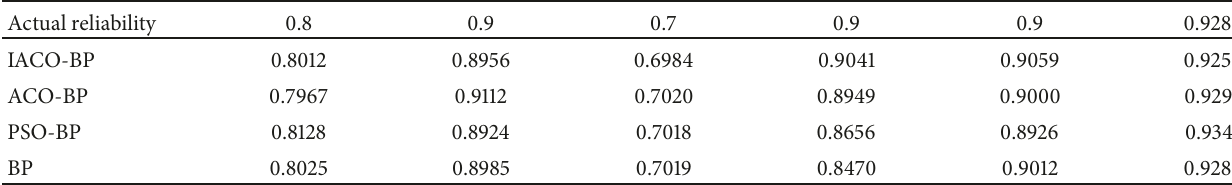
Table 7: Comparison of reliability